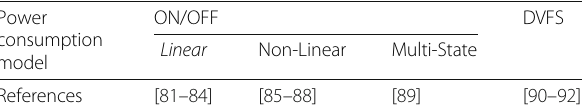
Table 12 List of Assumptions and alternative possibilities: Power consumption Models of servers as a function of workload